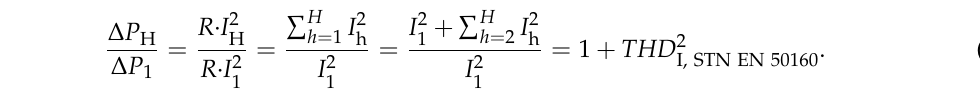
Figure 15. The dependence of increasing APLs from three-phase active power consumption for ACSR